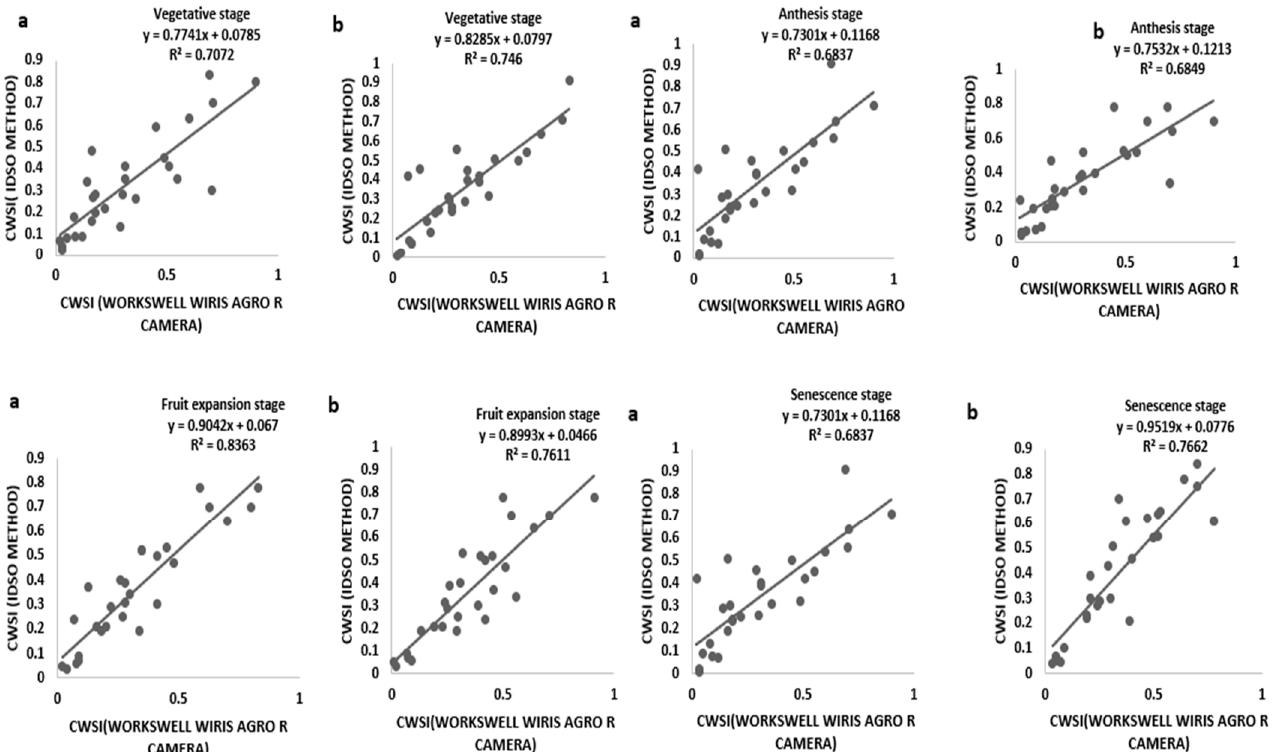
Figure 9. Relationship between the CWSI IDSO and CWSI W (( a ) sandy loam soil ( b ) silt loam soil) at different growth